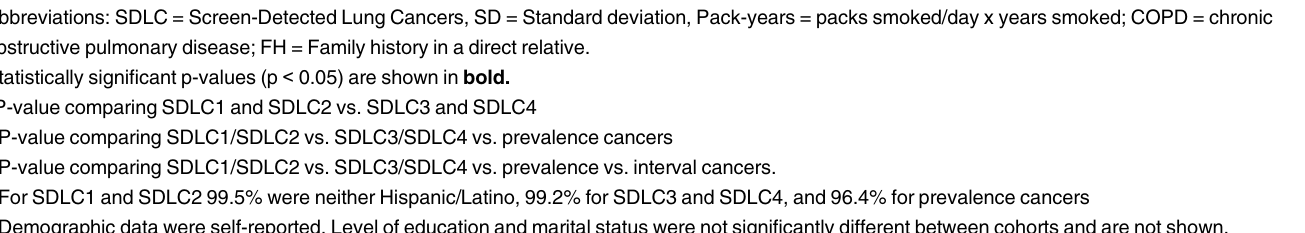
with no reported deaths were significantly higher than in the SDLC3/4 cases (132 participants [67.4%] vs. 62 participants[49.6%]). Lung cancer deaths were nearly equal in number between the two combined screen-detected cohorts, but the percentage was significantly lower in the SDLC1/2 cases (27.0% vs. 43.2%). There was also a significant difference in all cause deaths when comparing the combined screen-detected cases to prevalence cases (P = 0.028), largely driven by the reduced lung cancer death rate in the SDLC1/2 cases. Lung cancer deaths were highest in those with interval cancers (79.6%), which was significantly different from the screen-detected and prevalence cases (P < 0.001). The overall- and lung cancer-specific death rates were significantly higher for the SDLC3/4 cases (159.6 per 1000 person-years and 136.6 per 1000 person-years) compared to SDLC1/2 cases (86.2 per 1000 person-years and 71.3 per 1000 person-years). Kaplan-Meier survival analyses were used to calculate 5-year survival rates (Table 3) and compare differences in PFS and OS between the lung cancer case groups. Across all lung cancer case groups, PFS (Fig 2A) was significantly highest in the SDLC1/2 case group than the SDLC3/4 cases (P < 0.001), prevalence (P = 0.031), and interval cancer cases (P < 0.001). Simi- lar findings were observed for OS (Fig 2B). PFS and OS were lowest in the interval cancers; PFS